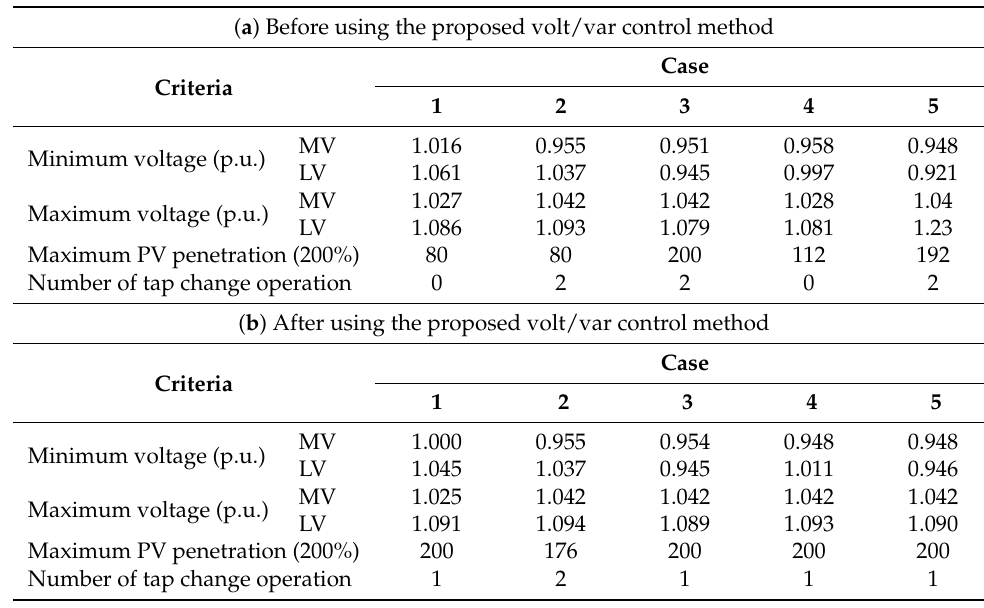
Table 3. Summary of results.